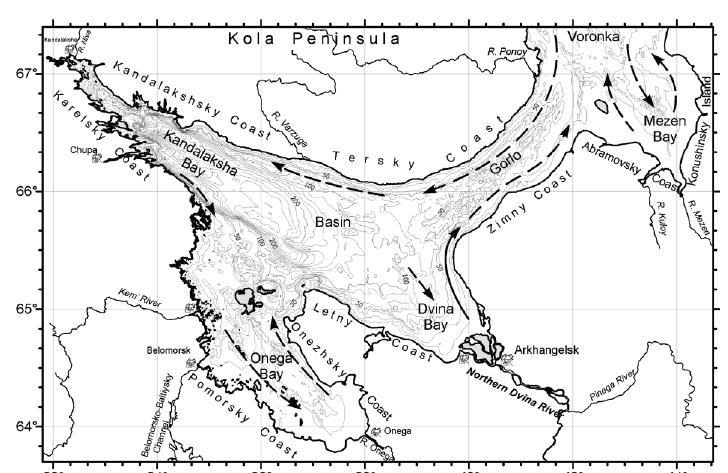
Fig. 1 Map of the White Sea, its bathymetry (based on IO RAS and GEBCO bathymetry) and major currents (data from Pantyulin 2003).